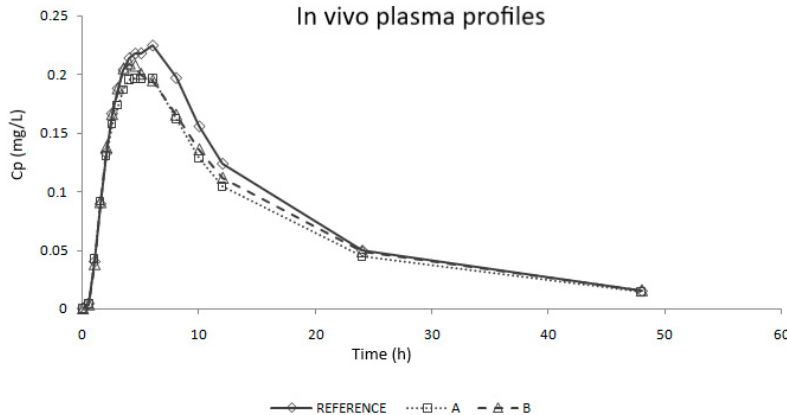
Figure 1. Average plasma concentrations versus time profiles of in vivo studies after correction/scaling based on the reference product.